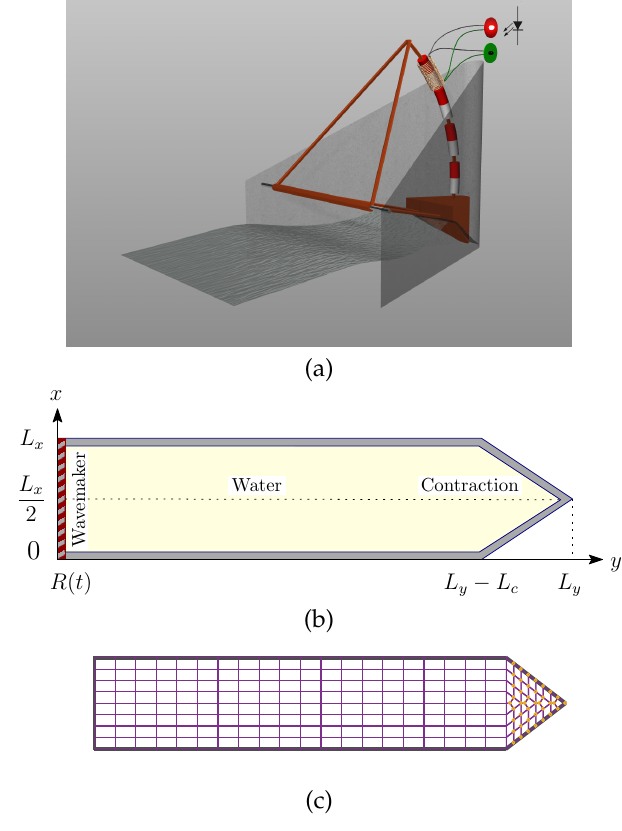
Fig. 2. (a) Sketch of our wave-energy device with its horizontal axle at the contraction entrance, and its three-dimensional tetrahedral buoy in the corner of the contraction. The buoy is attached to an induction motor, consisting of magnets on the arc moving through the hollow cylindrical coils indicated in yellow, while the LEDs are shown with green and red. (b) Top-view schematic of the wave- energy tank used in the simulations, and (c) the finite-element